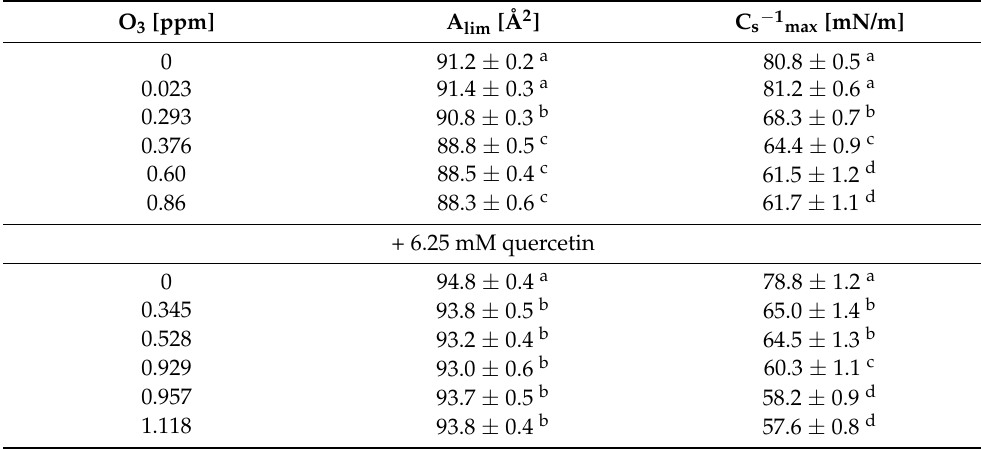
Table 3. Surface parameters of monolayers A lim and C s − 1 calculated for monolayers of the model of neuroblastoma membrane spread on the subphase contained the indicated concentrations of ozone dissolved in the buffer in the absence and in the presence of quercetin (6.25 µ M). Data represent mean from three experiments ± SD. Different letters indicate significant differences ( p ≤